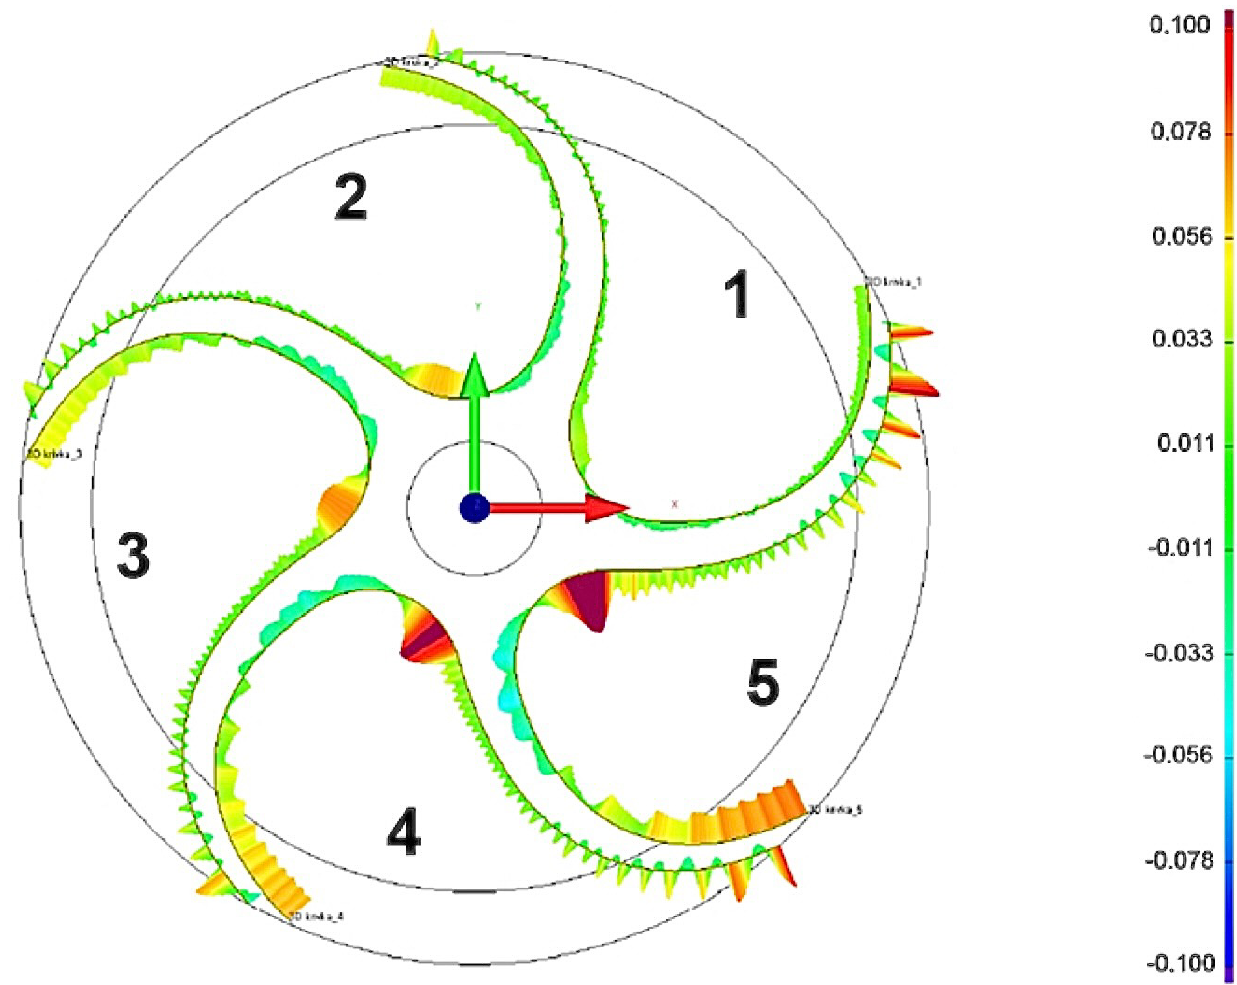
Figure 6. Deviations on the sidewalls of the sample made with the optimization software. Table 4. Comparison of sidewall deviations of